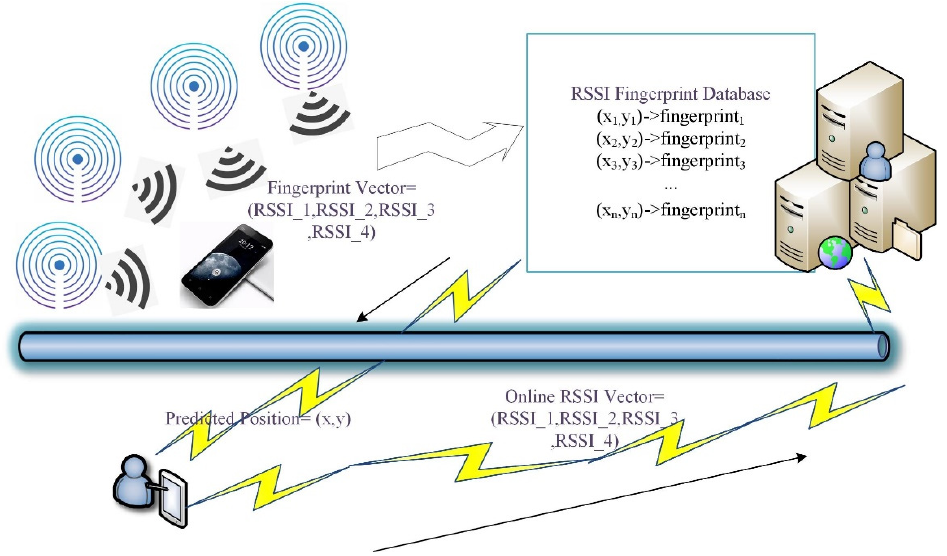
Figure 3. The general process of the establishment of an offline fingerprint database and online po-